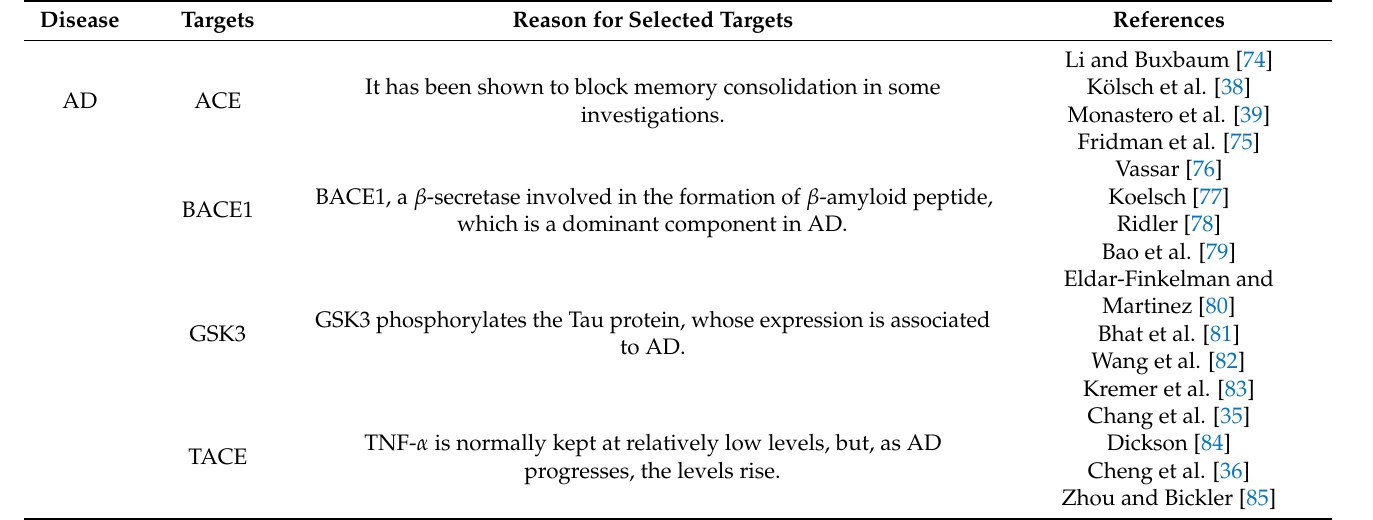
Table 4. Targets in AD and